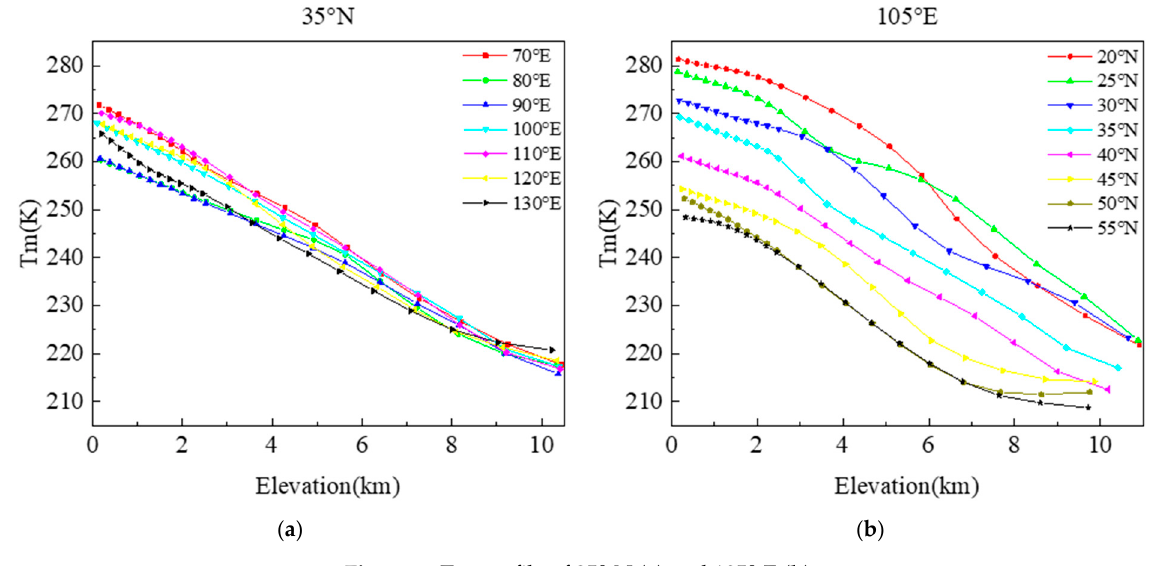
Figure 2. Tm profile of 35° N ( a ) and 105° E ( b ).